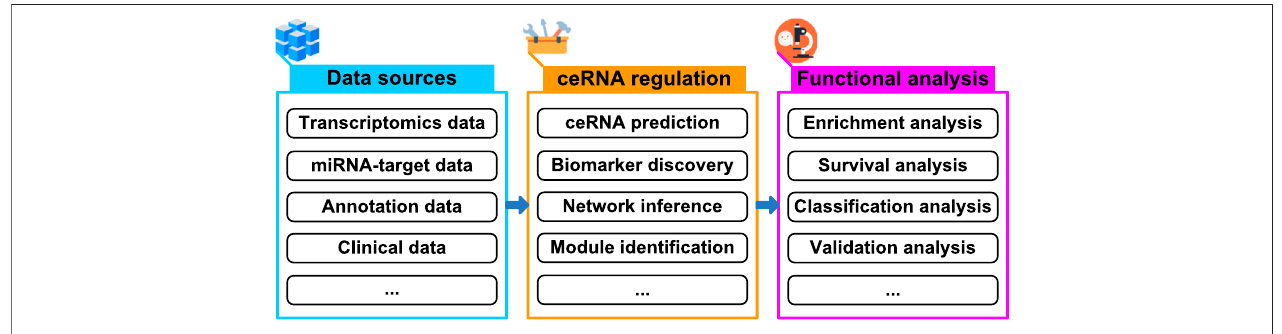
FIGURE 1 | Schema of exploring ceRNA regulation from multiple data